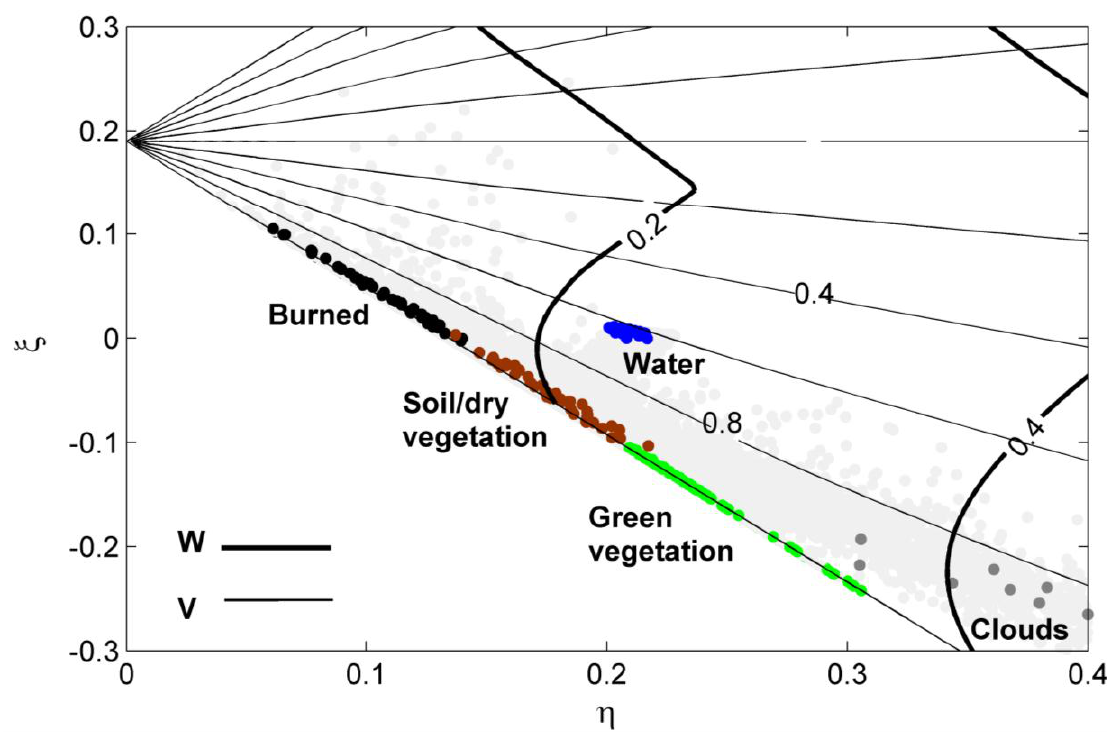
Figure 2. Contours of W (thick lines) and V (thin lines) in the η/ξ space. Light gray dots denote MODIS pixels from Cerrado. Selected pixels corresponding to burned surfaces, soil/dry vegetation, vegetation, clouds and water are, respectively, highlighted in black, brown, green, dark gray and